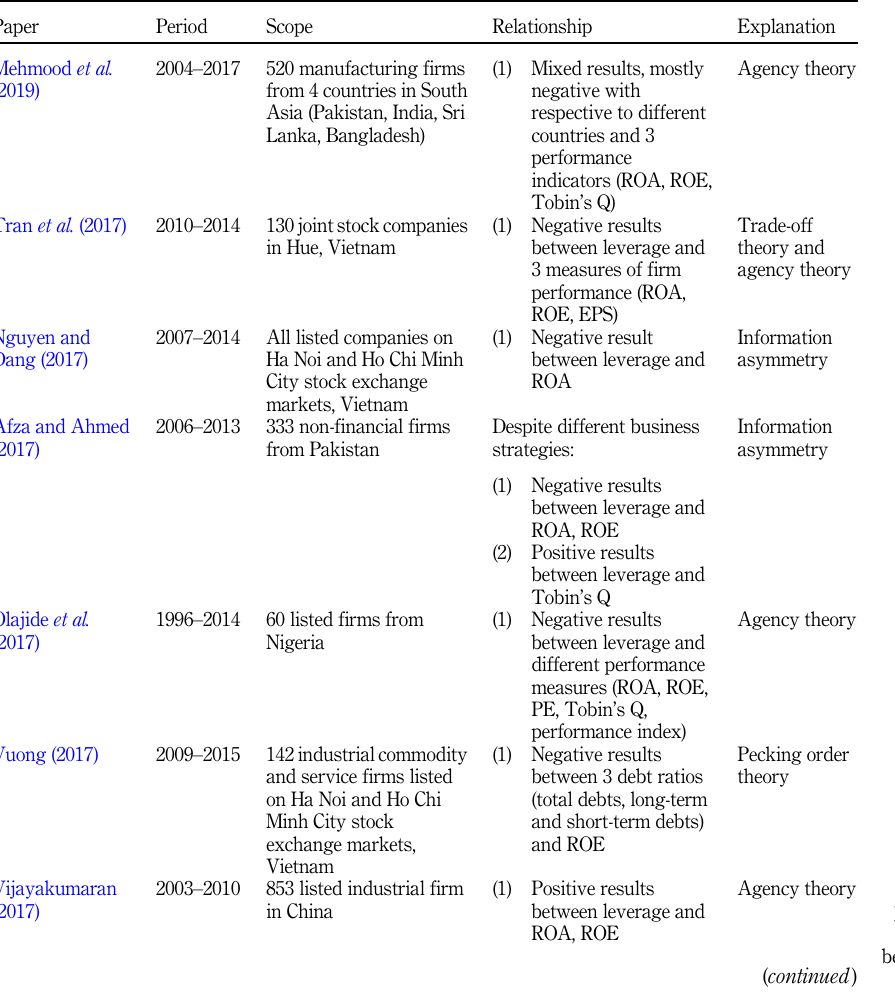
Table A1. Empirical results